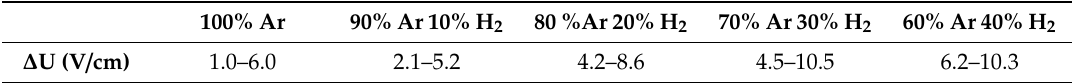
Table 11. Change in voltage per centimeter of arc height for mixtures of argon and hydrogen in comparison to pure